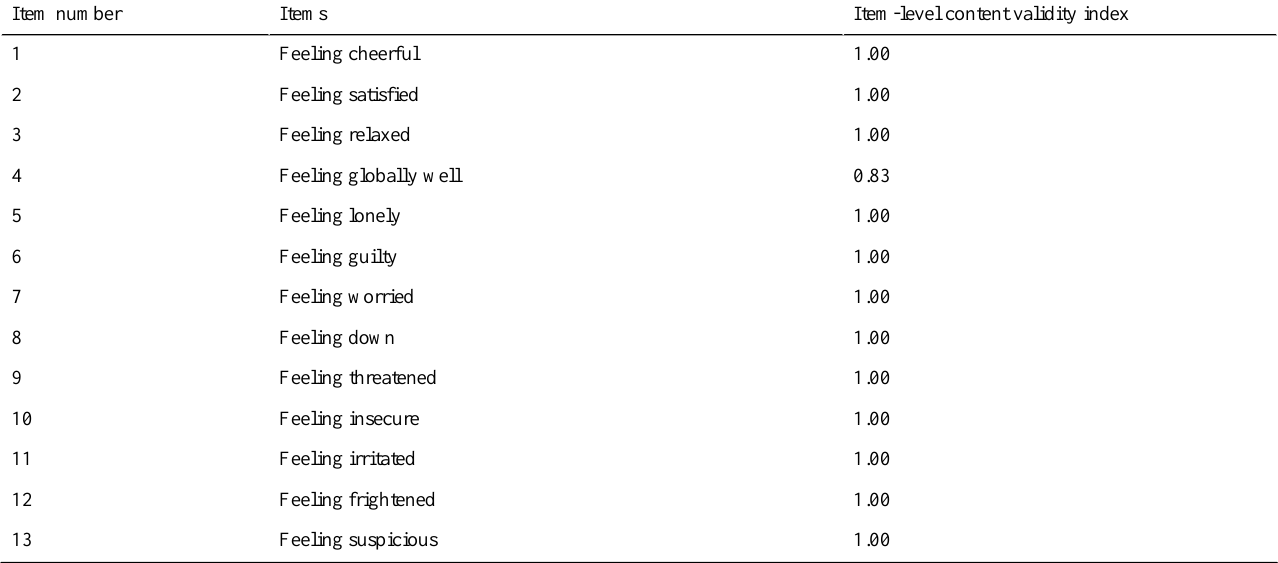
Table 1. Item-level content validity index of the PsyMate items